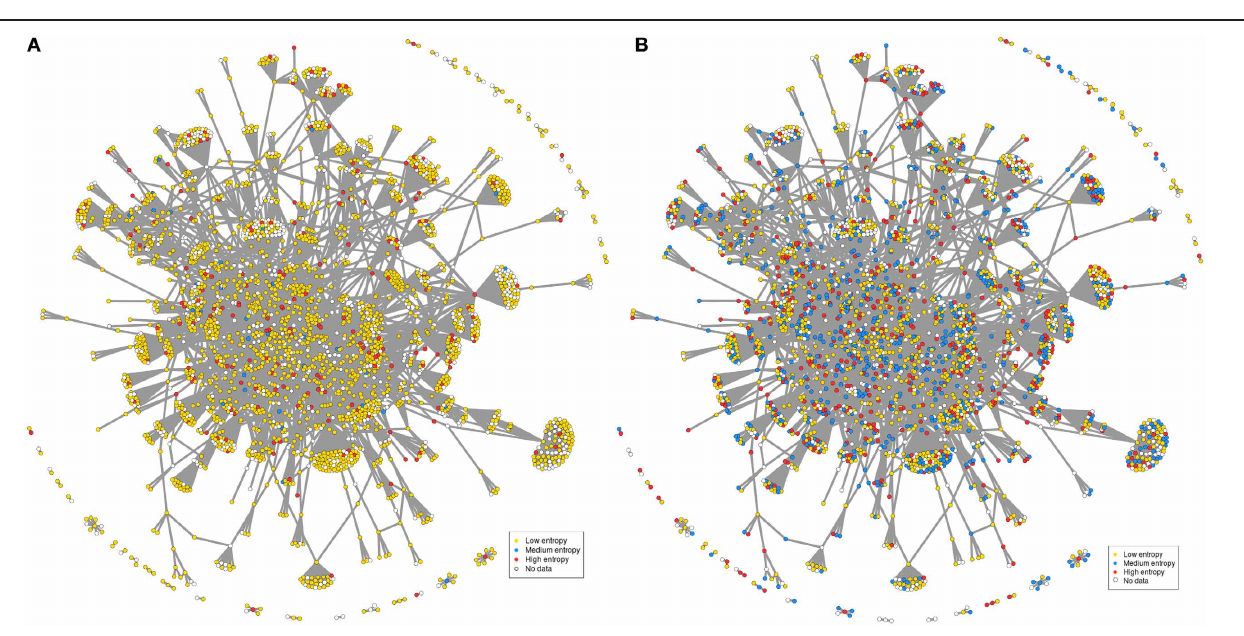
FIGURE 5 | Context-dependent distribution of gene entropy values in FOXO3-interaction networks. The network used in this figure is the same as in Figure 1 , except for labels of gene nodes. The categories for gene entropy used in this figure are the same as